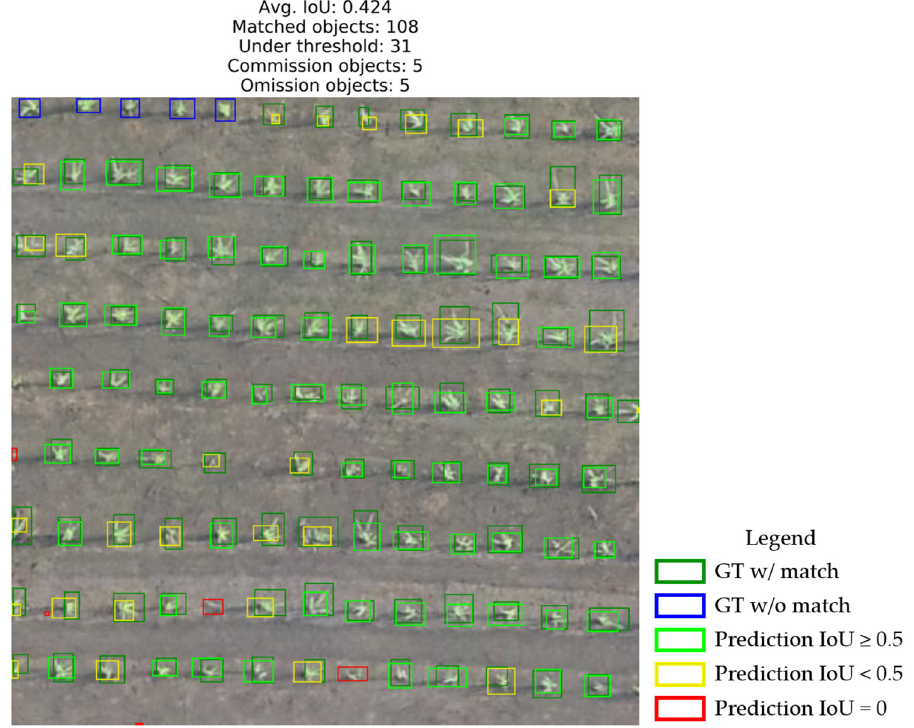
Figure 11. An example of HOG-SVM detection result on test data.